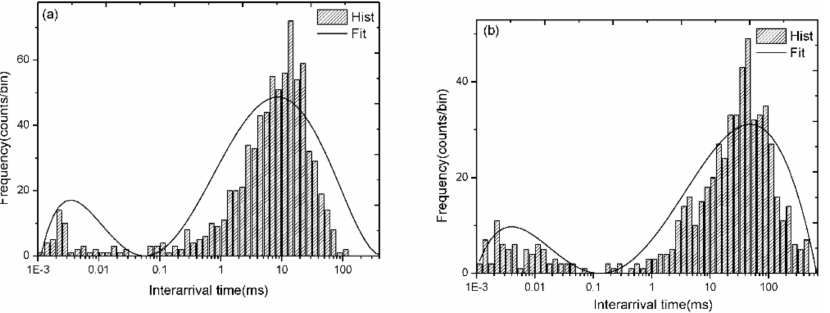
Figure 3. Interarrival time statistics and curve fit results of the first short period in S1 and C1: ( a ) S1; ( b )